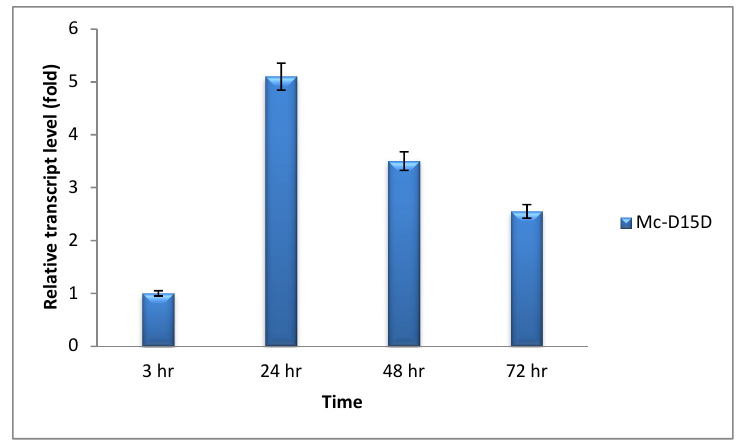
Figure 3. Determination of expression levels of delta-15 desaturase ( D15D ) genes by RT-qPCR in the recombinant strains.